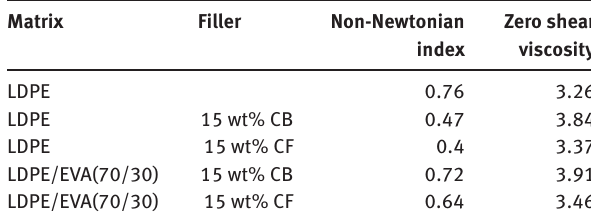
Table 3: Non-Newtonian index and zero shear viscosity of